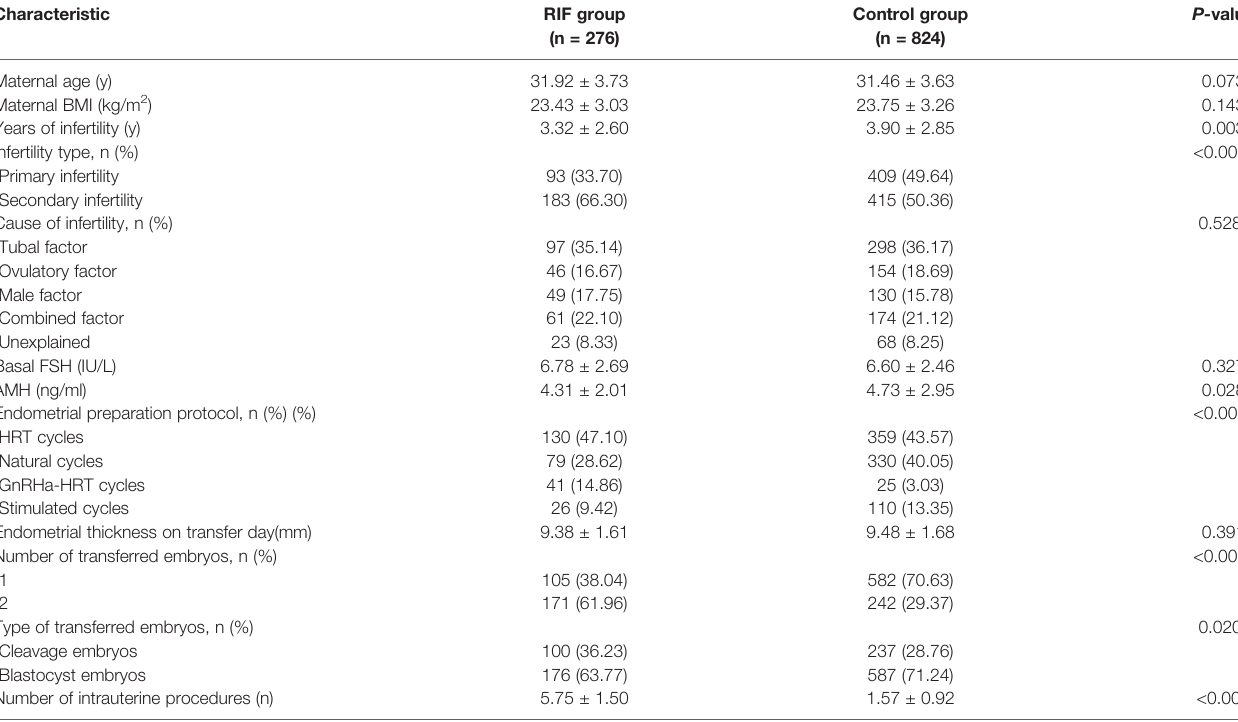
TABLE 1 | Demographic characteristics of women with a singleton birth following FET in the RIF group and control group.